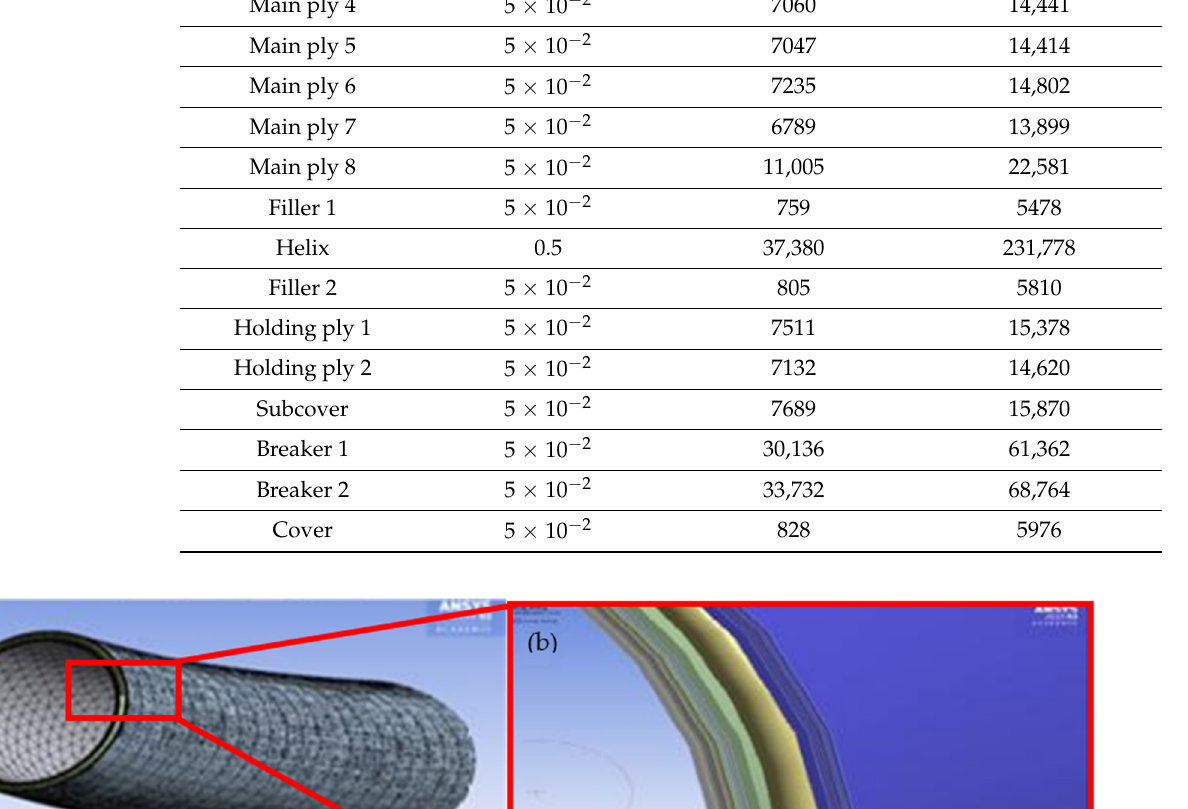
Table 5. Mesh sizing details as applied for each layer of the reeling hose.